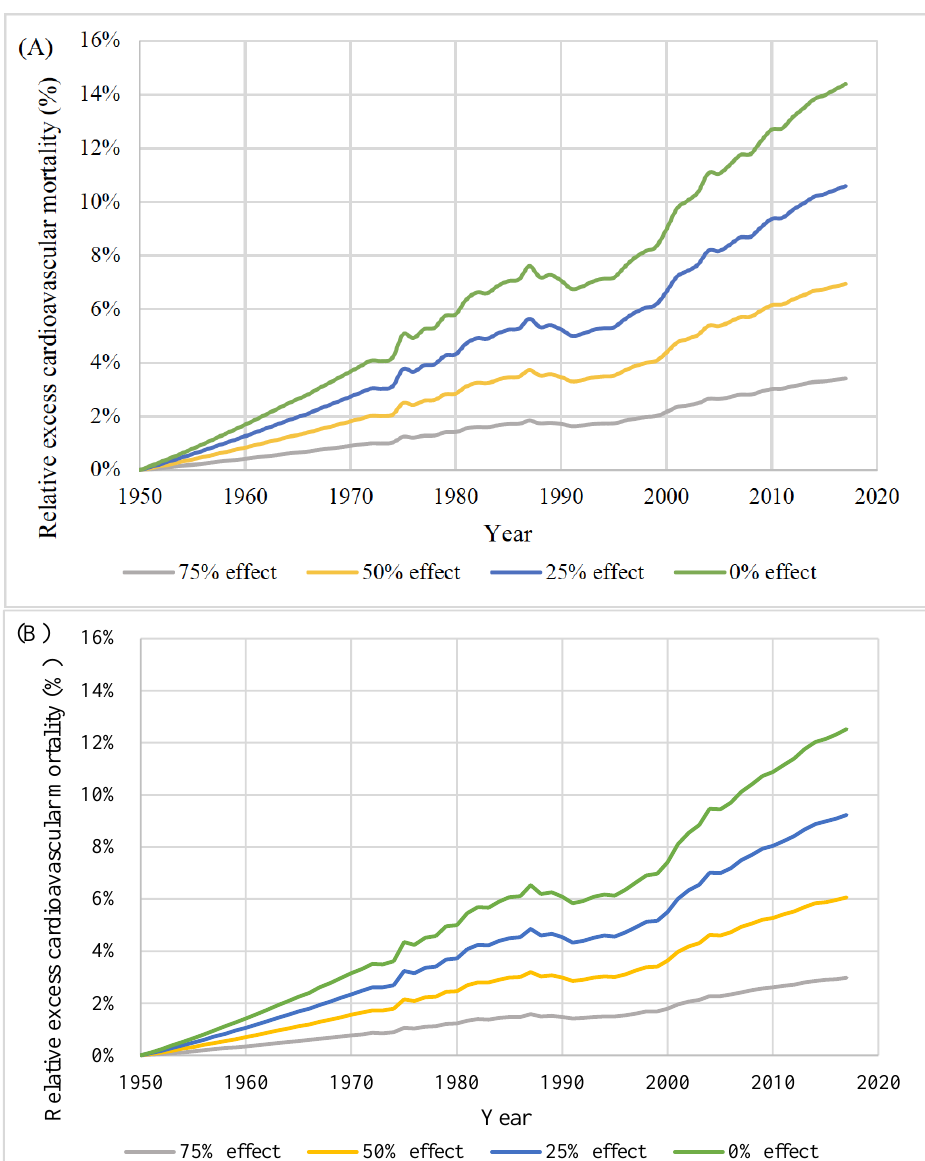
Figure 5. Relative excess cardiovascular mortality by scenario in men ( A ) and women ( B ): 75% effect, 75% of the actual effect of salt-intake reduction; 50% effect, 50% of the actual effect of salt-intake reduction; 25% effect, 25% of the actual effect of salt-intake reduction; 0% effect, no effect of salt-intake reduction since 1950.